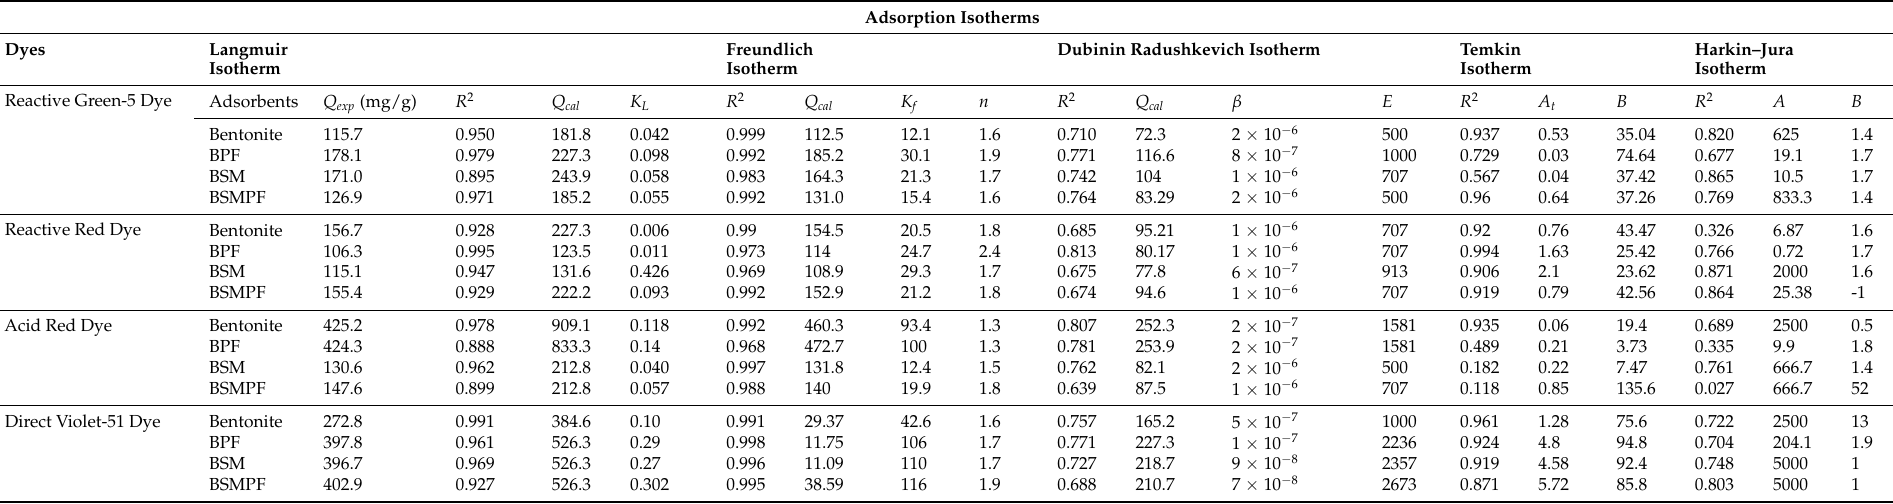
Table 1. Experimental data of adsorption isotherms for all